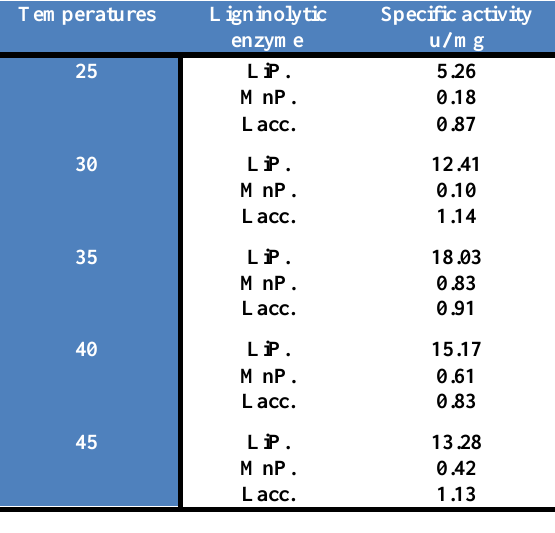
Table, 11: Ligninolytic enzymes production in different temperatures.